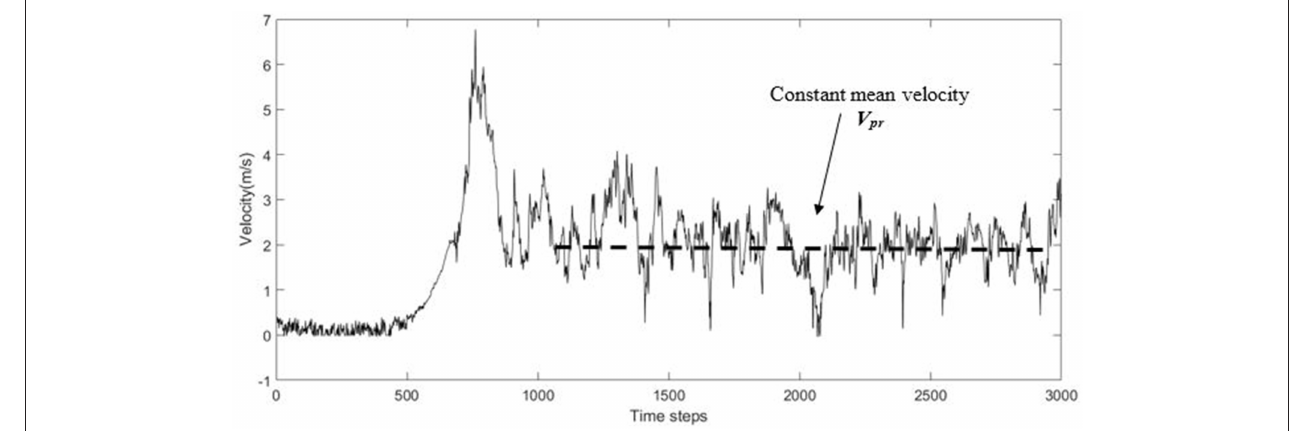
FIGURE 3 | Time history of radial velocity for a probe point.